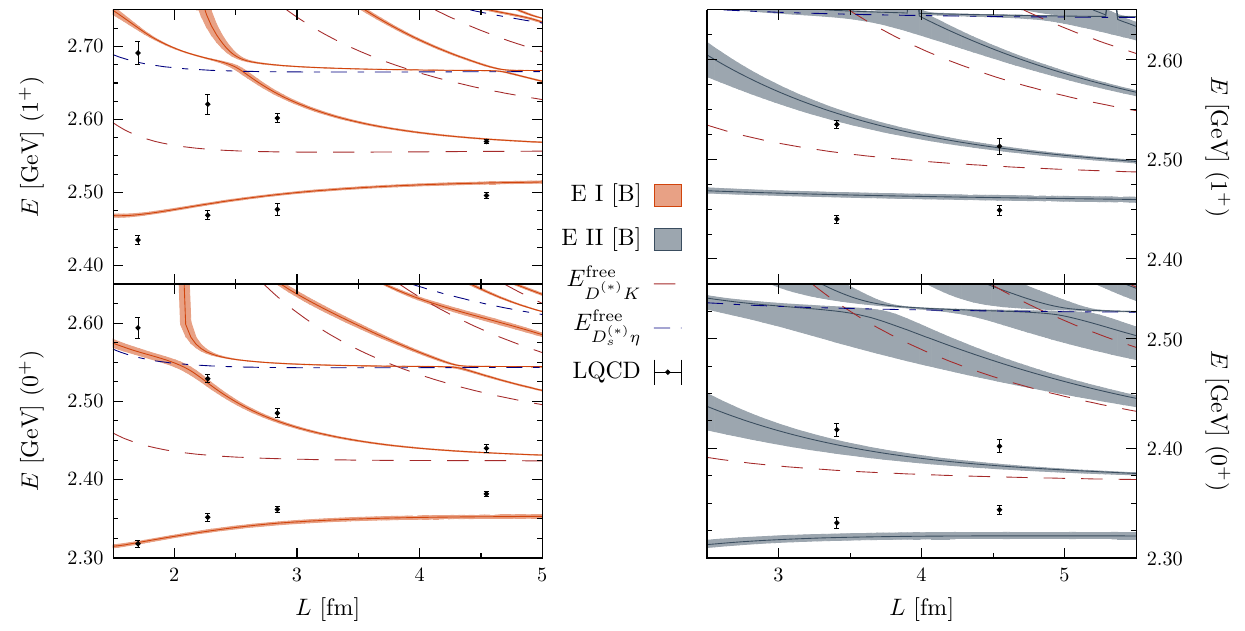
Fig. 2 Same as Fig. 1, but in this case the predictions have been obtained using the Set B of CQM bare